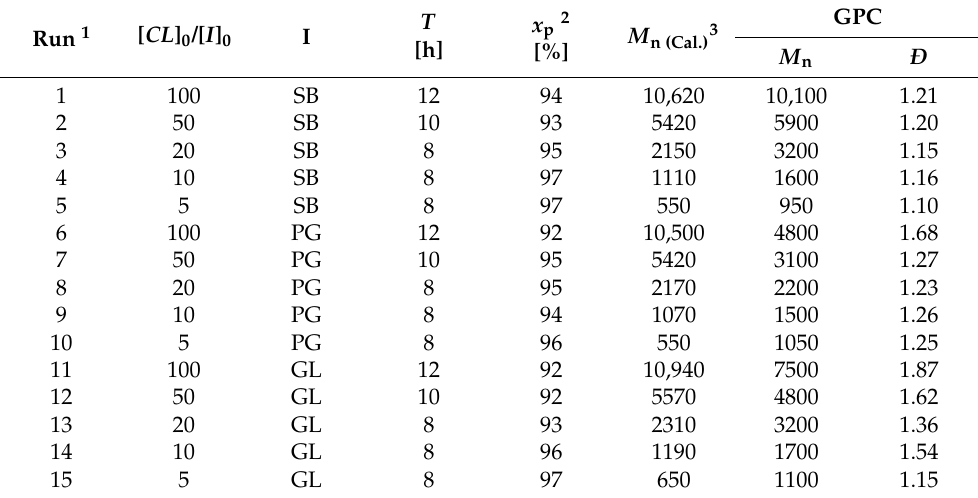
Table 3. Results for ROP of CL by DMC-EAA catalyst using various [ CL ] 0 /[ I ] 0 ratios.